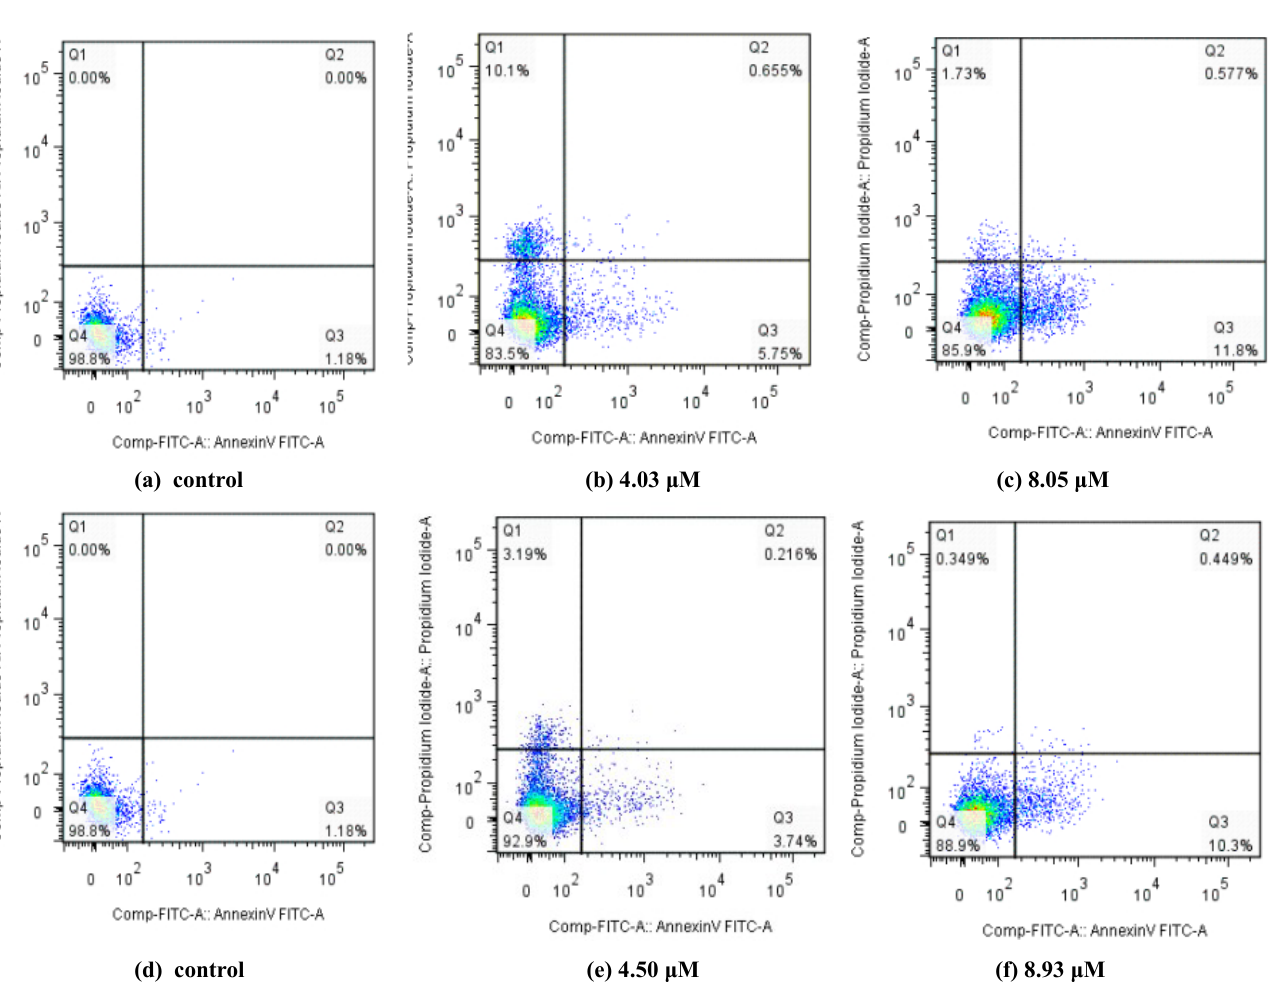
Figure 7. Apoptosis ratio detection of compounds 4h and 6h by Annexin V-FITC and PI. ( a , d ) The T24 cells not treated with compounds 4h and 6h were used as controls; ( b , c ) compound 4h treated T24 cells for 24 h at concentrations of 4.03 and 8.05 μM, respectively; ( e , f ) compound 6h treated T24 cells for 24 h at concentrations of 4.50 and 8.93 μM, respectively.